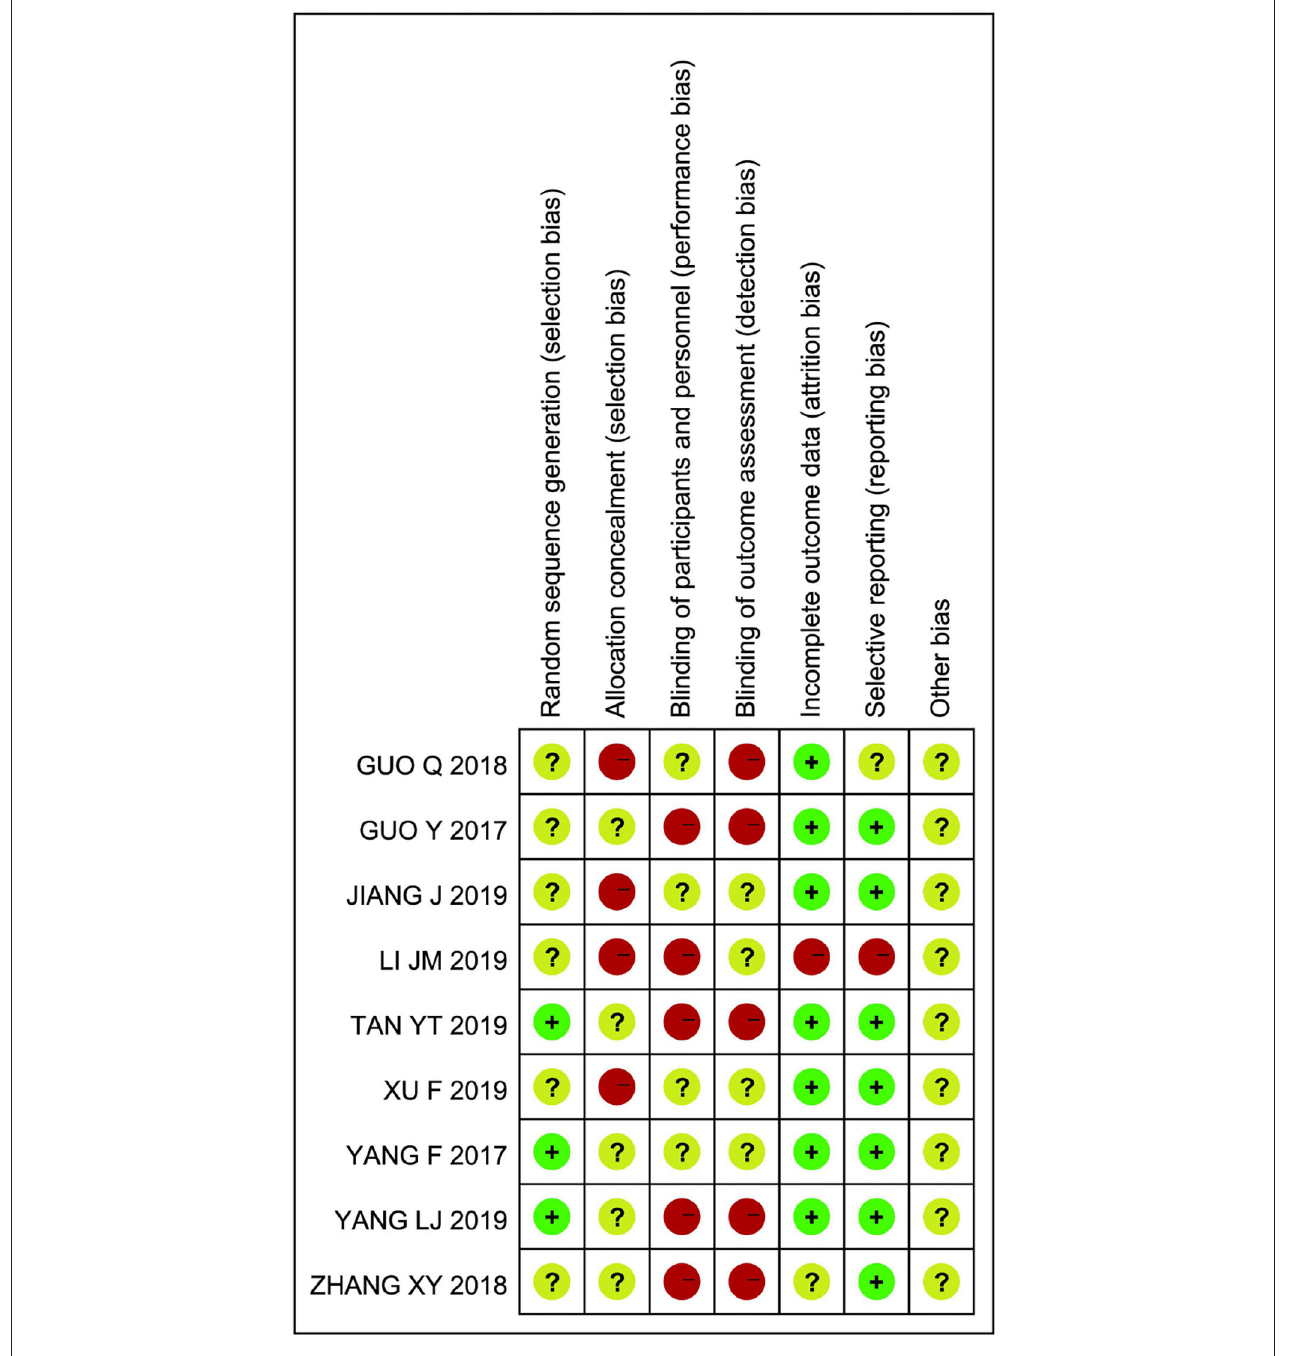
FIGURE 2 | Review authors’ judgements about each risk of bias item for each of included study.